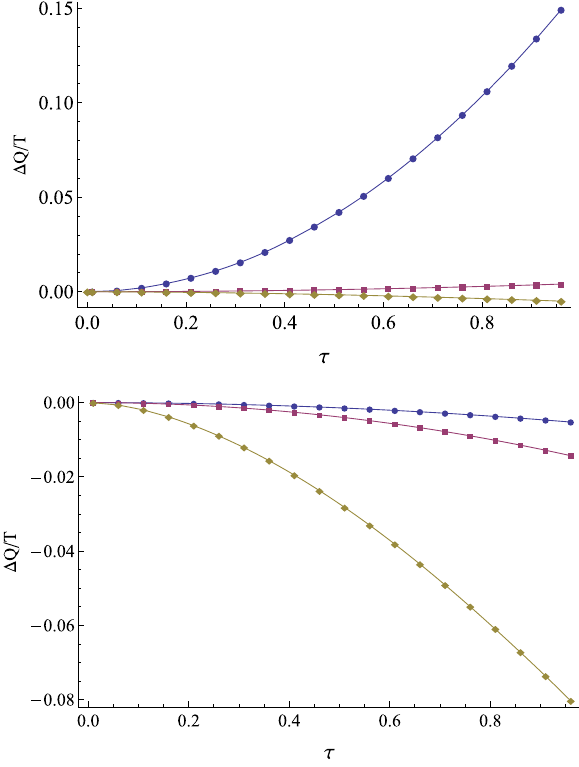
Fig. 1 The cases of T E = 1 and T E = 100 in single-mode approxima- tion. In both figures we set L = 1 . 234, (cid:6) = ω 20 , p = 0 . 2, x = 0 . 52345 in natural units. In each figure from top to bottom the curves correspond to (cid:5) Q / T E , (cid:5) S in process (19), and (cid:5) S in our case with decoherence,